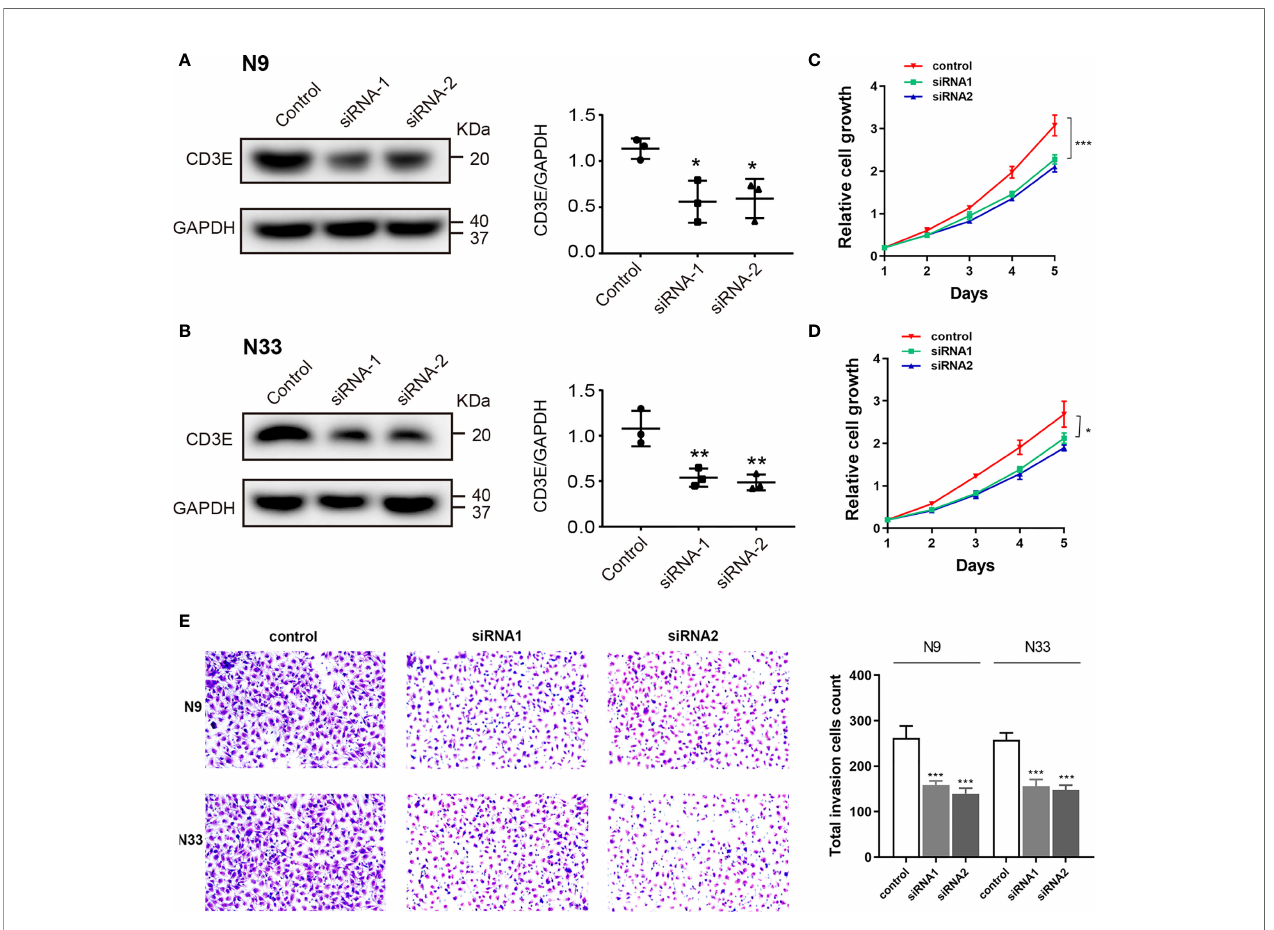
FIGURE 13 | Down-regulation of CD3E inhibits cell proliferation and invasion abilities in LGG cells. (A, B) Western blot showed that CD3E protein expression was markedly decreased after siRNA-CD3E transfection. (C, D) CCK8 assay showed that the decreased CD3E expression signi fi cantly inhibited cell proliferation in N9 and N33 cells. (E) Transwell assay showed that when expression of CD3E was inhibited, the invasion ability of N9 and N33 cell lines was signi fi cantly